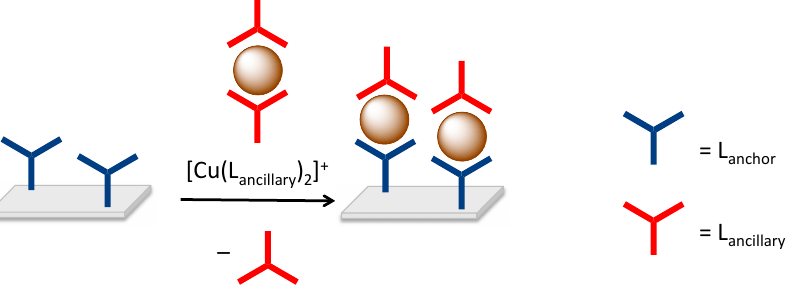
Figure 5. The SALSAC approach to a TiO 2 -bound heteroleptic copper(I) dye using ligand exchange.